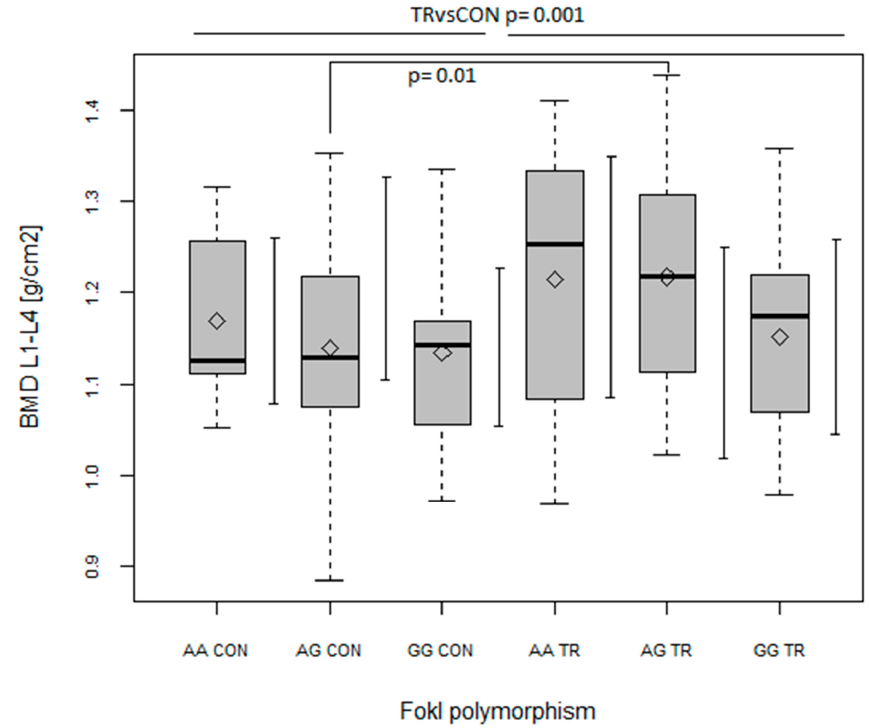
Figure 5. The effect of FokI polymorphism on bone mineral density (BMD) (g/cm 2 ) of the lumbar spine (L1–L4) in control (CON) and trained (TR) group. Main effects: FokI ( p = 0.047; F = 2.95). TR vs. CON ( p = 0.001; F = 10.46). Key: ♦ —mean; boxplots—median Q1–Q4 and mean ± SD.